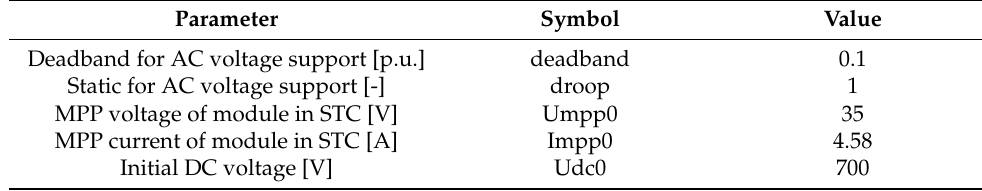
Table 3. Working conditions corresponding to different types of three-phase short-circuit fault. Fault